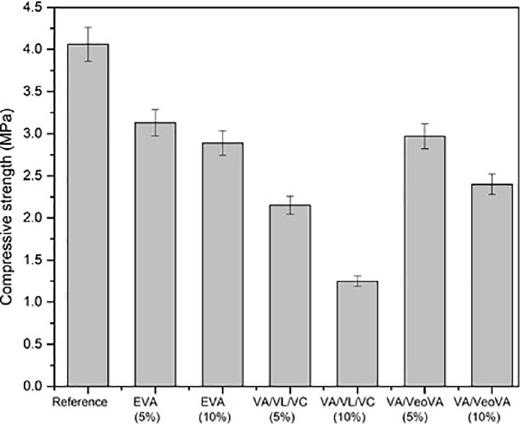
Figure 4. Compressive strength of modified gypsum.